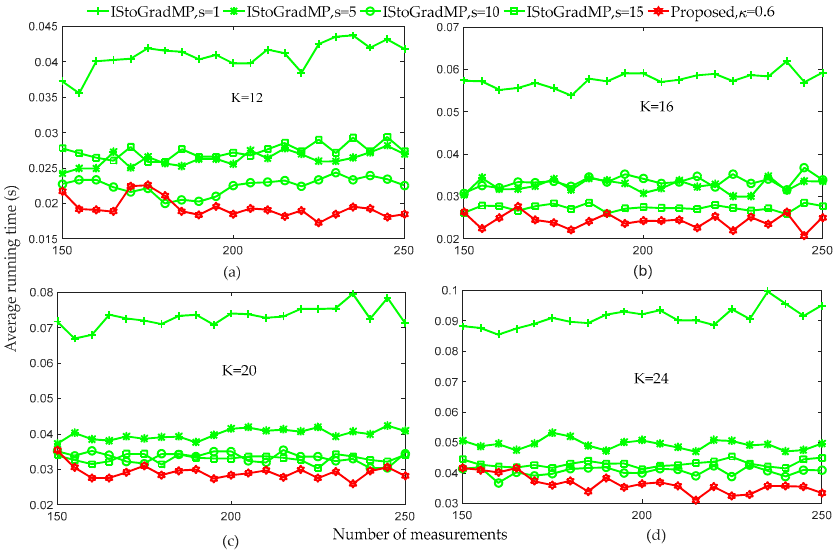
Figure 9. Average running times of the proposed algorithm and IStoGradMP algorithm ( n = 256, κ = 0.6, K = 12,16,20,24, s = 1,5,10,15, m = 150 : 5 : 250, δ